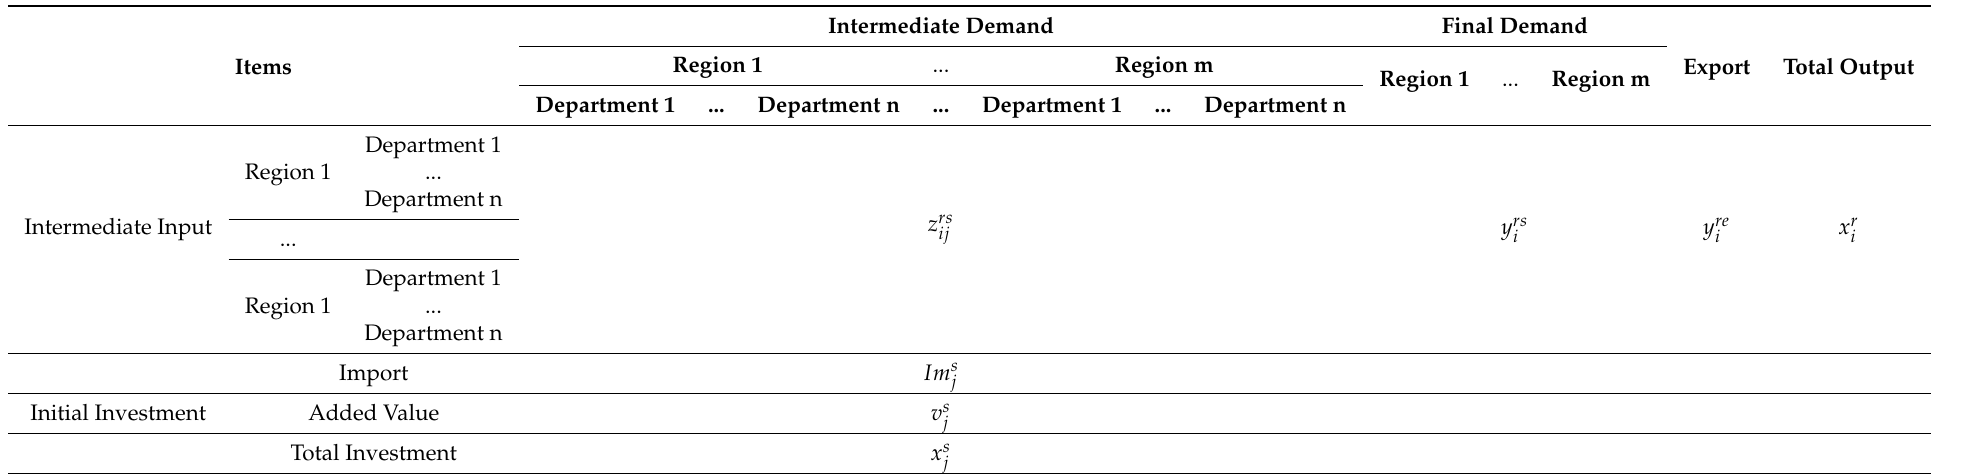
Table 5. The structure of multiregional input–output